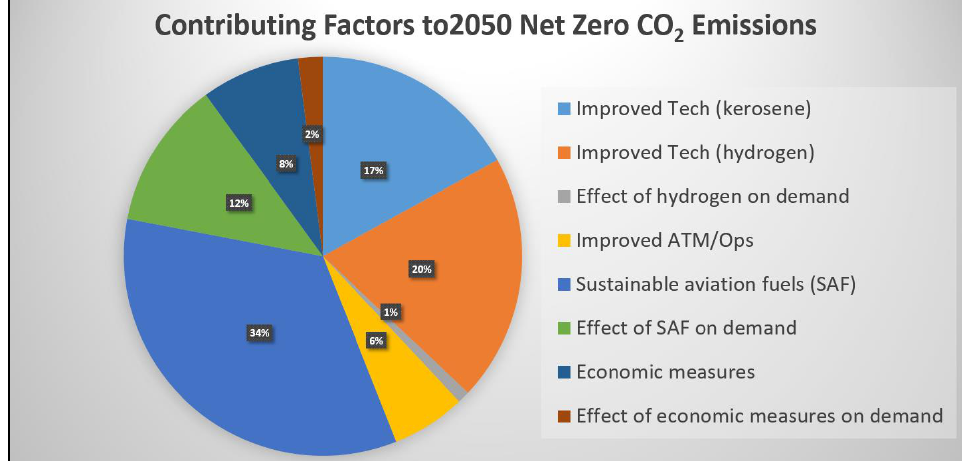
Figure 2. Decarbonization roadmap showing key efforts needed to achieve carbon-neutral aviation in Europe by 2050 [3].